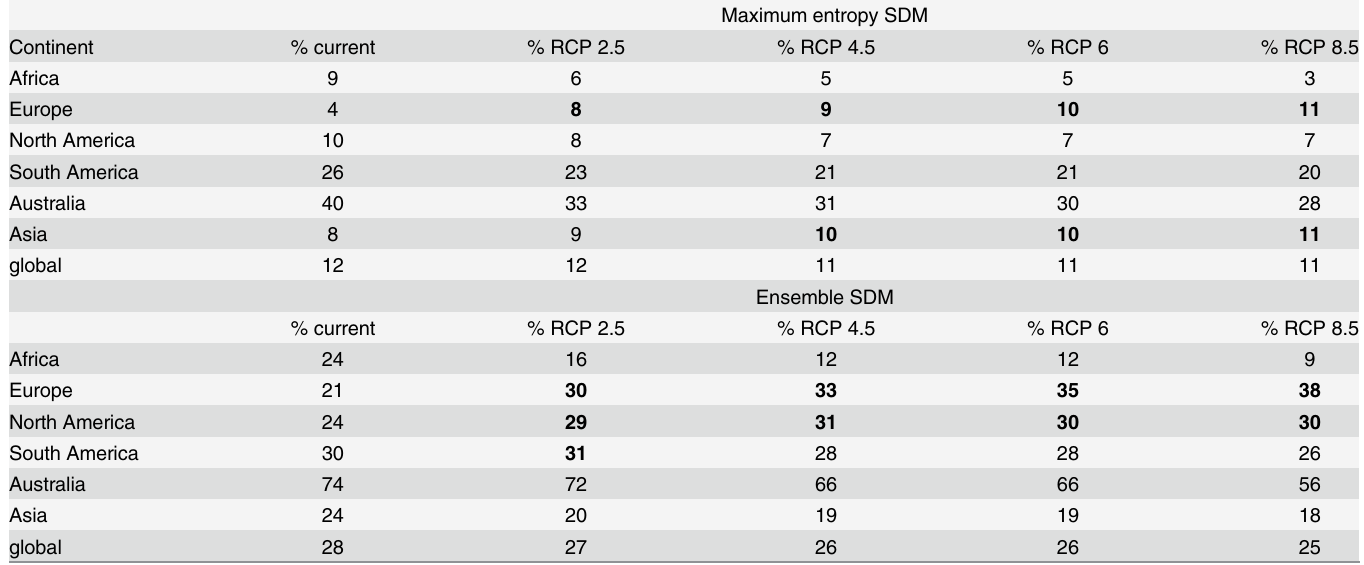
Table 2. Environmentally suitable space given as percent of the world ’ s surface area for current climatic conditions and projections onto climate change scenarios. Percentages refer to the SDM-MESS area; values increasing with climate change scenarios are displayed in